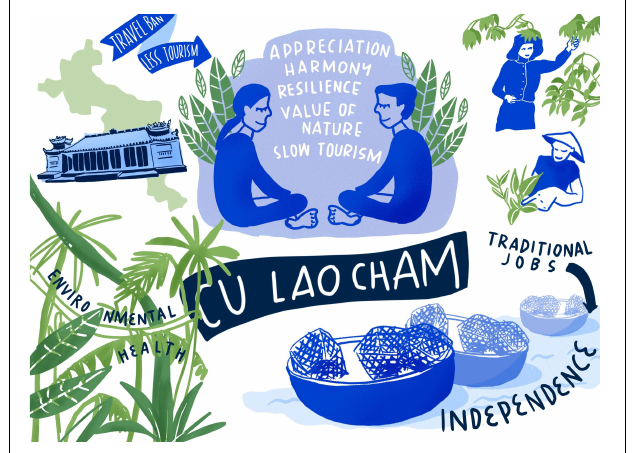
FIGURE 3 | COVID-19 scenario for Cu Lao Cham. Illustration by Lina Ernst